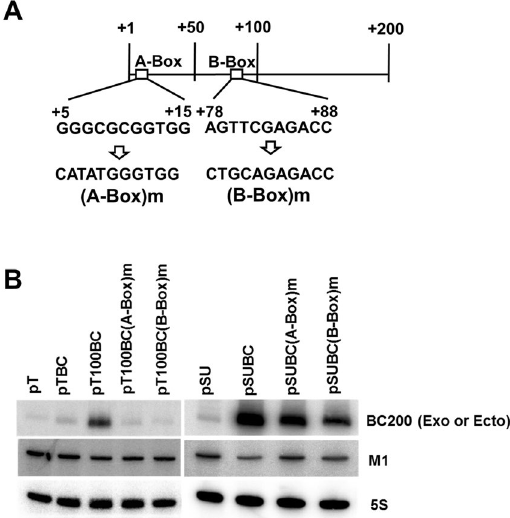
Figure 4. Effects of the putative A and B boxes on BC200 RNA transcription. ( A ) Schematic diagram of the proposed consensus A and B boxes in the BC200 RNA structural sequence. Each mutated sequence is shown after an arrow. ( B ) The − 100 nt upstream constructs carrying the A or B box mutations were introduced into HeLa cells. The cells were transfected with 1 µ g of plasmids expressing BC200 RNA or its derivatives, and 1 µ g of the M1 RNA expressing plasmid. The BC200 RNA structural sequence carrying the same mutations were cloned into the pSUPER vector (pSU) to ectopically generate BC200 RNA transcripts from the H1 RNA promoter. The pSUPER derivatives (pSUBC series) were also introduced into HeLa cells. Total RNA was prepared and subjected to Northern blot analysis. BC200 (Exo) and BC200 (Ecto) stand for endogenous and ectopic BC200 RNA,